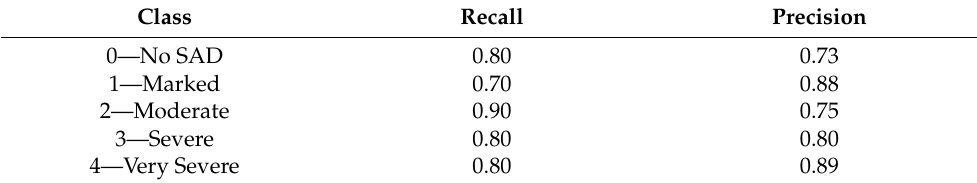
Table 5. Recall, precision score of SAD classes.